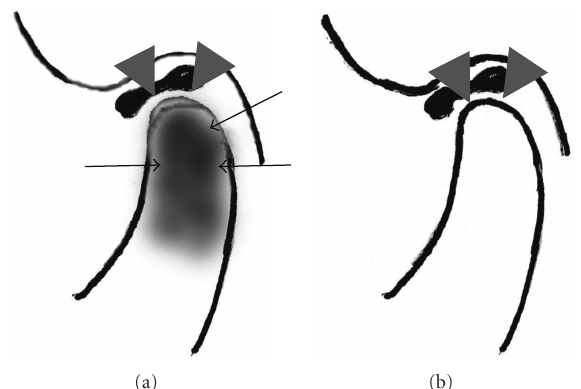
Figure 3: Scheme of the alternation of the top of mandibular condyle according to age. (a) In schoolchildren with DCLS, cancerous bone, hypervascular loose fibrous tissues, and proliferation of cartilage are laminating and conglomeritic (arrowheads). In addition, red marrow is inside the mandibular condyles (arrows). (b) In older subjects with disappearance of the DCLS, maturing bone (a cortical bone-like state), hypovascular loose fibrous tissues, and thinner cartilage are laminating (arrowheads).